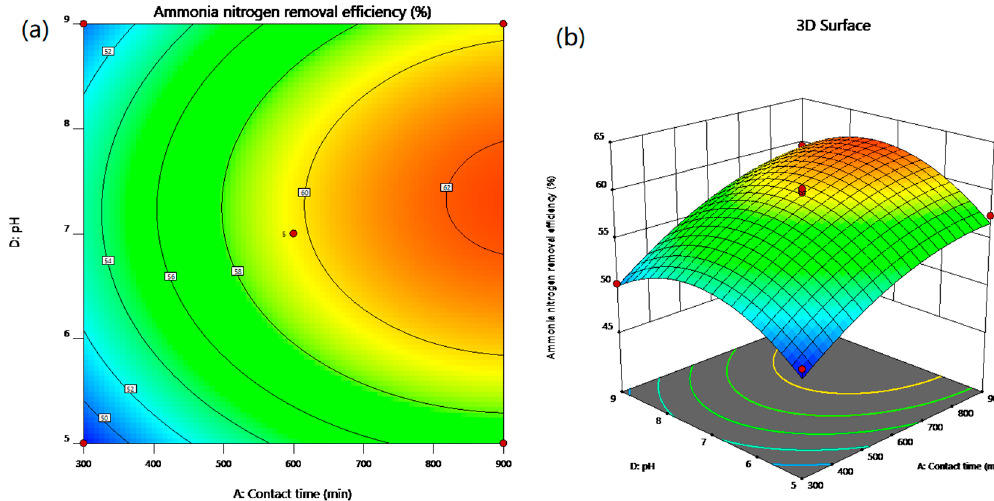
Figure 7. 2D contour plot ( a ) and 3D response surface plot ( b ) showing the effect of contact time and pH on the removal rate of NH 4 + .